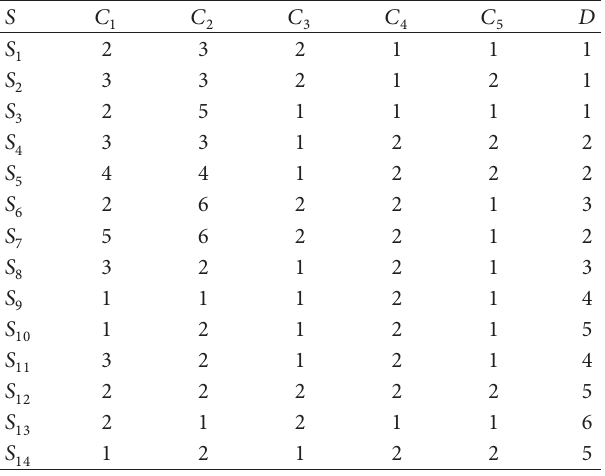
Table 2: The classification of sample